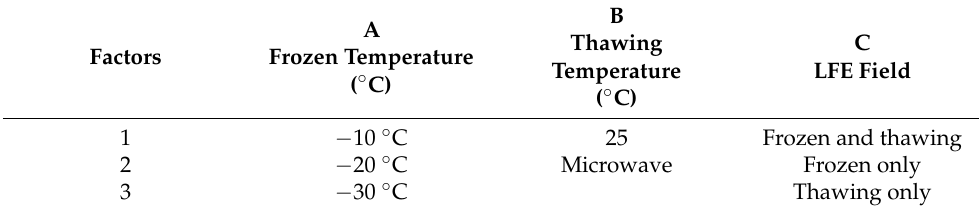
Table 1. Frozen–thawed orthogonal experimental design table.